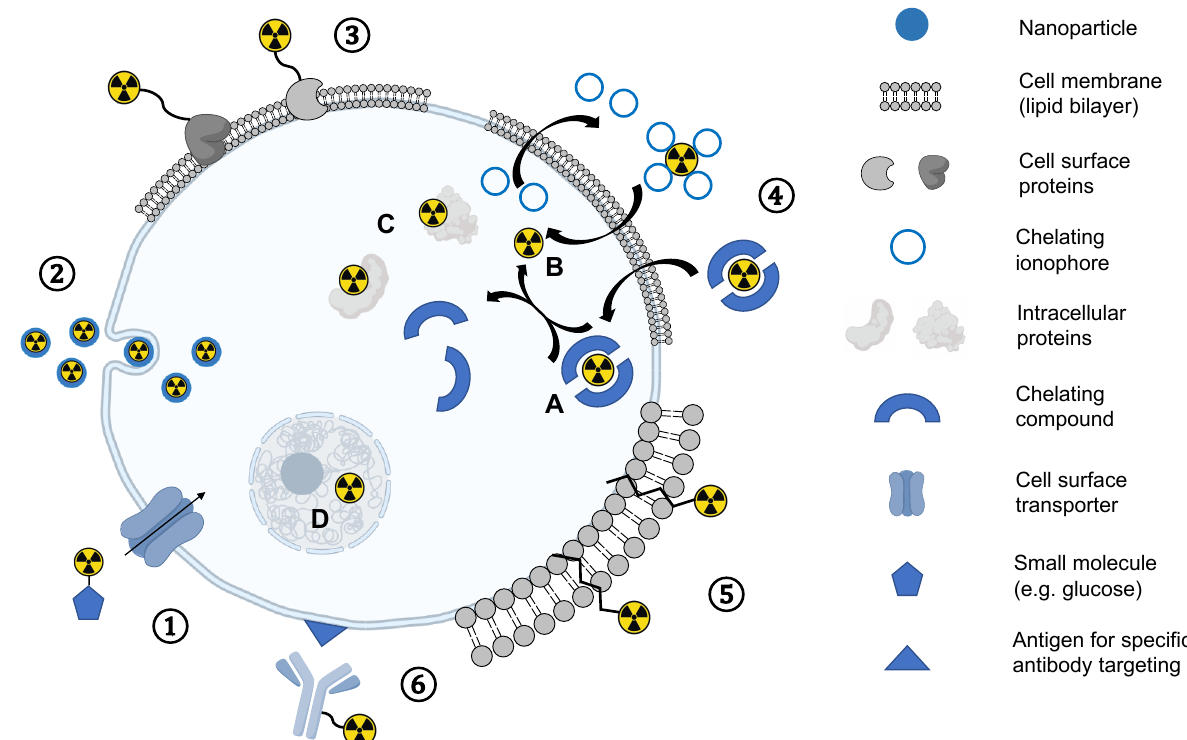
Figure 1. Overview of different direct cell labelling methods: 1 (cid:13) Uptake mediated by cellular transporters of small molecules (e.g., small molecules). 2 (cid:13) Endocytosis mediated uptake of nanoparticles. 3 (cid:13) Cell surface protein labelling. 4 (cid:13) Passive diffusion through the lipophilic cell membrane either as an intact chelate inside the cell ( A ) or dissociating in the cytosol ( B ) and association with intracellular proteins ( C ) or cell organelles ( D ). 5 (cid:13) Insertion of ligands into the lipophilic